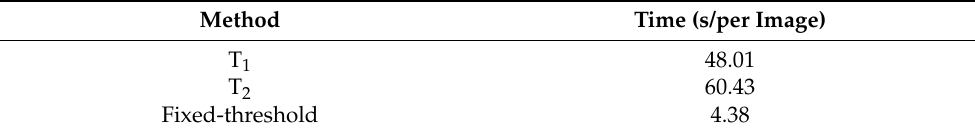
Table 7. The time to estimate FVC of maize using three different threshold methods in R with a 2.4 GHz computer